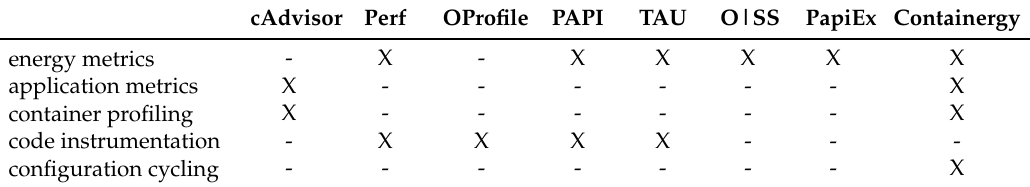
Table 1. Profiling